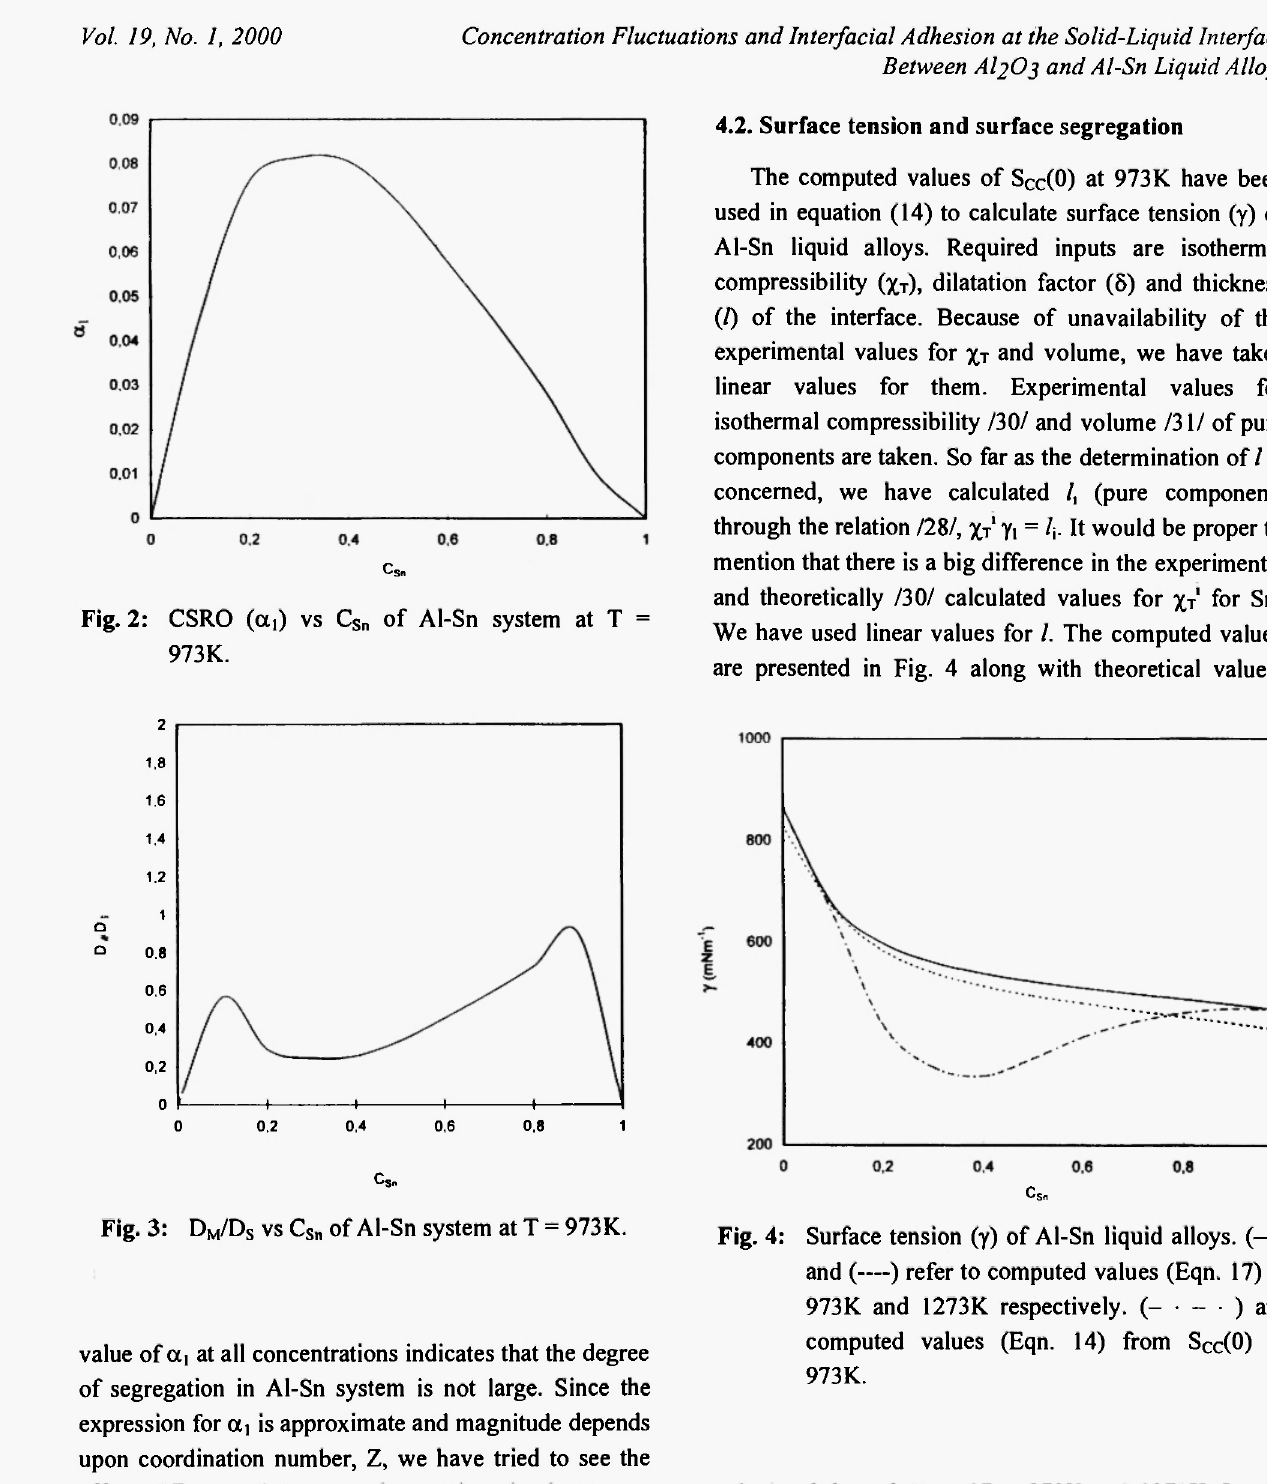
Fig. 4: Surface tension (γ) of Al-Sn liquid alloys. (—) and (—) refer to computed values (Eqn. 17) at 973Κ and 1273Κ respectively. ( - · - ·) are computed values (Eqn. 14) from S C c(0) at